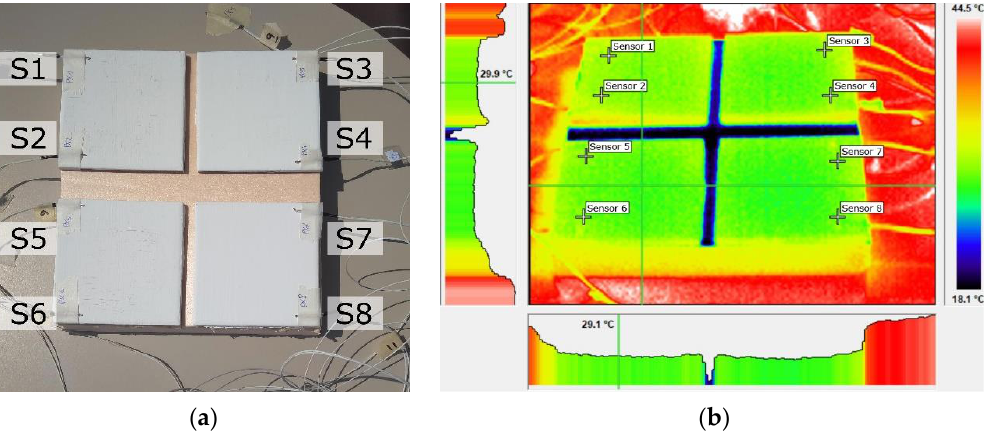
Figure 7. Position of NTC sensors ( a ), and thermographic picture E10 after adjusting the emissivity ( b ). Table 3. Technical specifications of the measuring devices used [52,53].